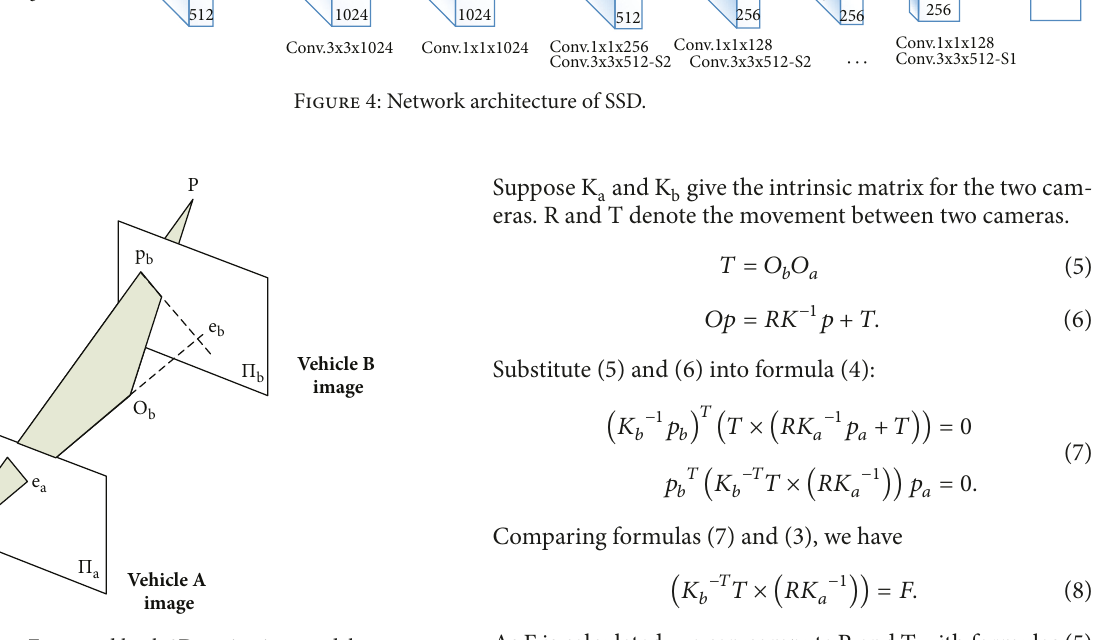
Figure 5: Front and back 3D projection